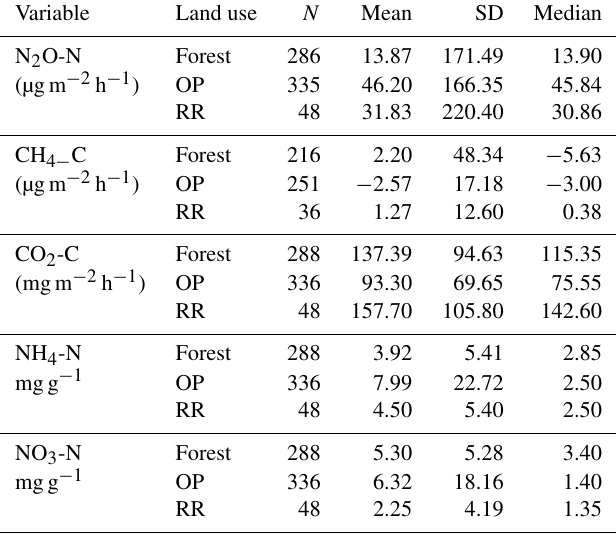
served from the young (OP2) and old (OP12) oil palm dividual chambers. In the logged forest, the largest fluxes were ∼ 400 µg m − 2 h 1 for individual chambers at site B. For each land use, standard deviation was a lot larger than